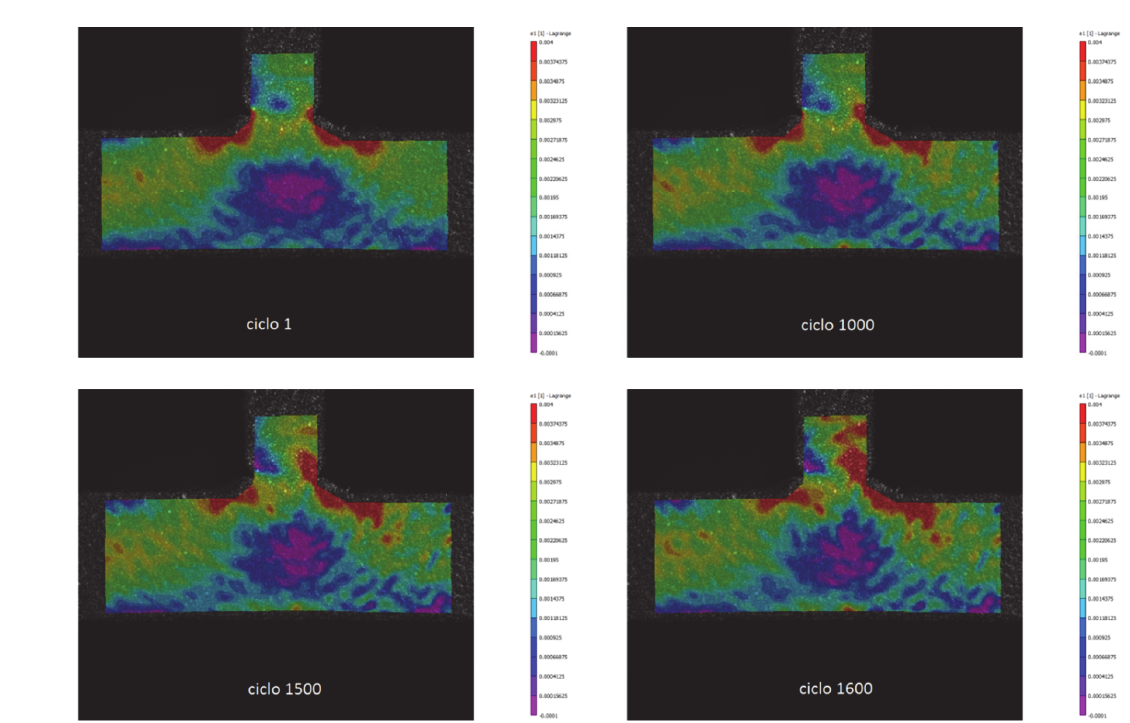
Figure 9: Maximum principal strain ( ε 1 ) measured at maximum load (40 kN) using the DIC for different load cycles.